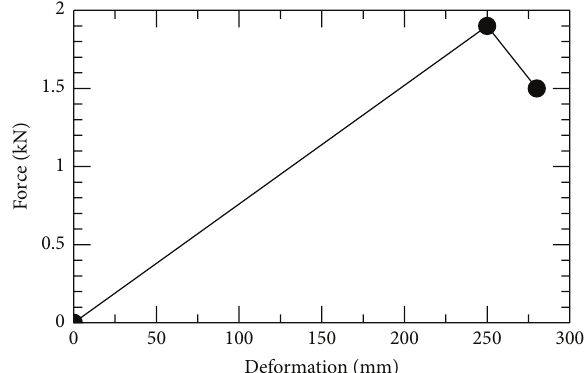
Figure 8: Simplified Force-displacement curve of used tires under radial compression.